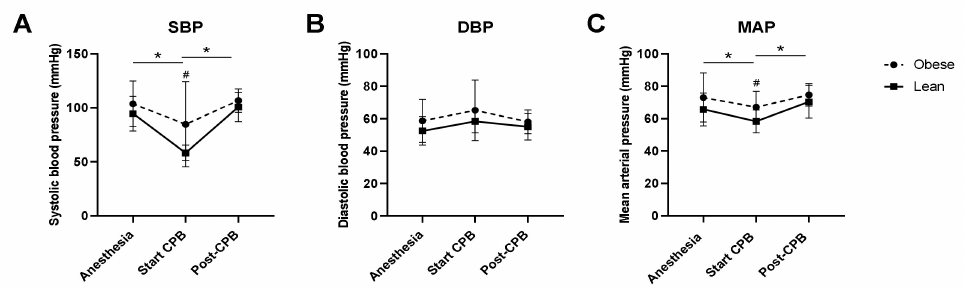
Figure 1. Intraoperative blood pressure. Mean arterial blood pressure (MAP; ( A )), systolic blood pressure (SBP; ( B )), and diastolic blood pressure (DBP; ( C )) measured after induction of anesthesia (anesthesia), 10 min after start of cardiopulmonary bypass (start CPB), and 10 min after weaning from CPB (post-CPB) in lean (black line) and obese (dotted line) patients. Data are represented by mean ± SD and tested with a two-way ANOVA and Bonferroni post hoc analysis; * p < 0.05 CPB effect; # p < 0.05 obese vs. lean patients.